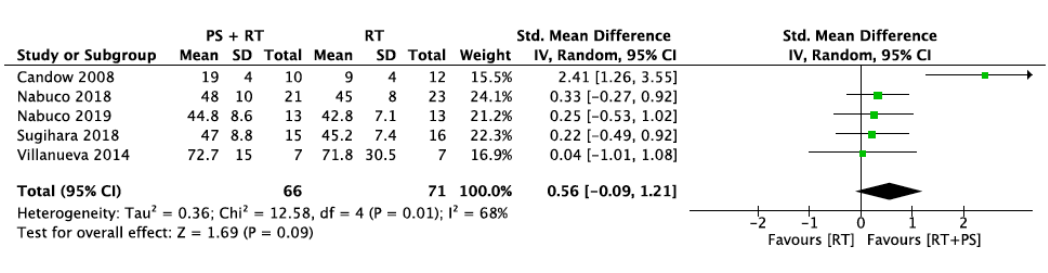
Figure 5. Impact of RT + PS on upper-limb strength.